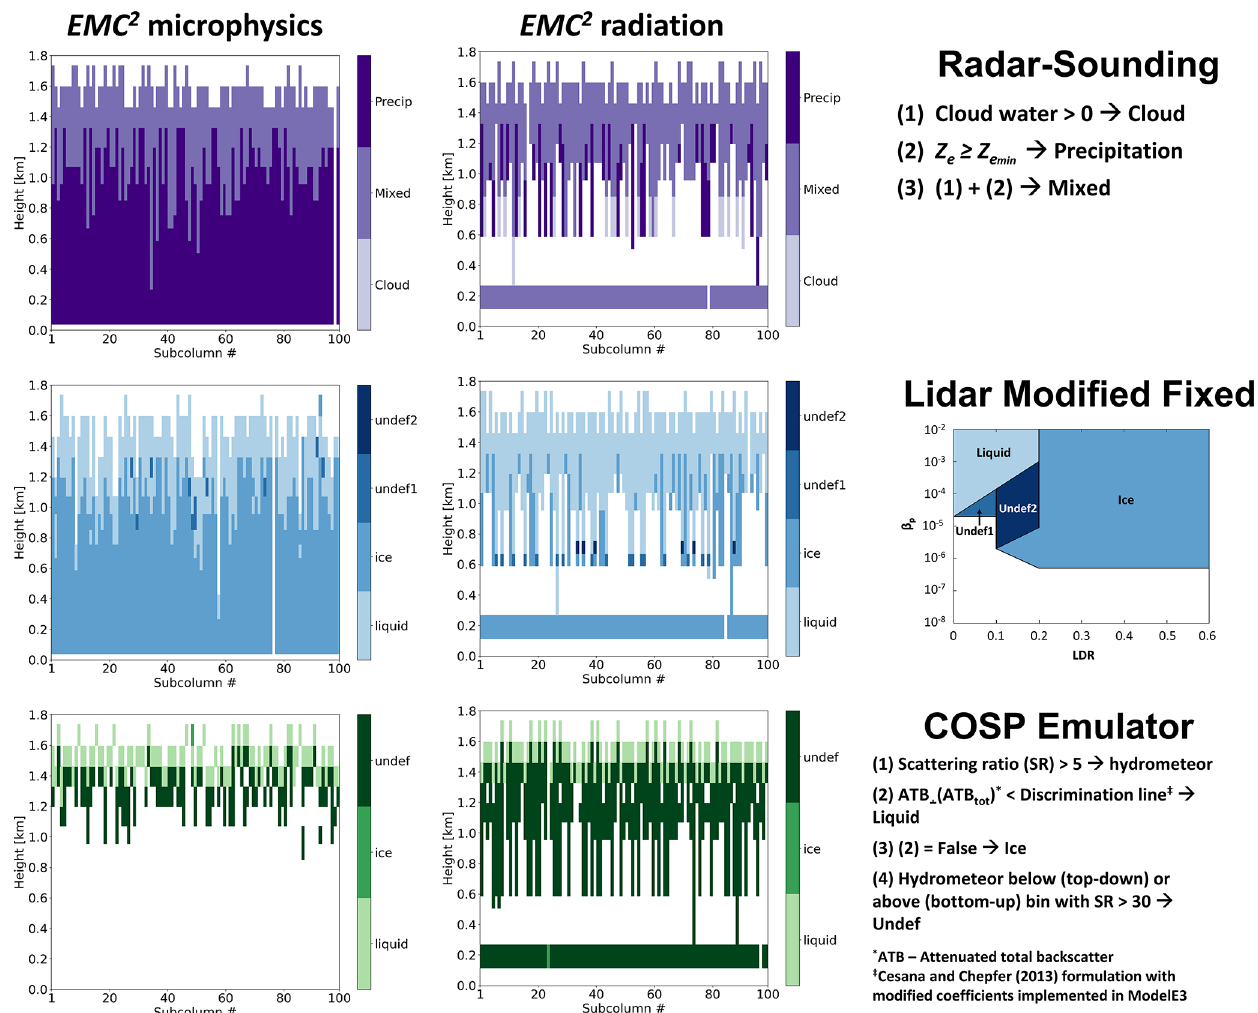
Figure 7. Hydrometeor classification of ModelE3 configuration Tun3 SCM output for 05:00UTC processed using EMC 2 ’s microphysics (left) and radiation (middle) approaches while considering signal attenuation and detectability: (from top to bottom) radar-sounding method, modified fixed lidar variable threshold method, and the COSP lidar simulator emulator (top-down view). (Right) Brief summary of each classification